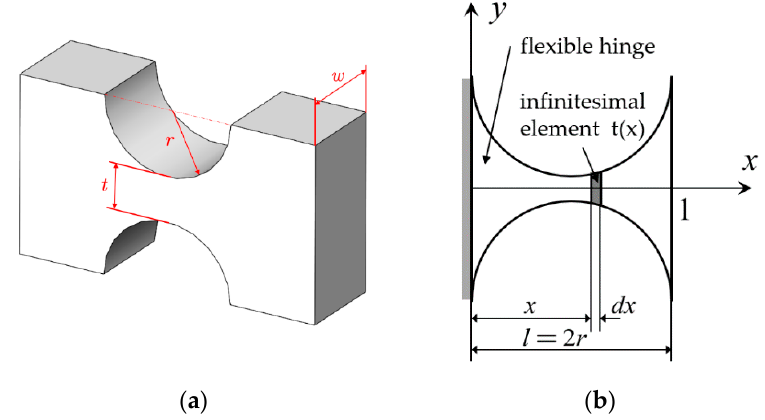
Figure 3. Flat single-axis straight circular flexible hinge. ( a ) Three-dimensional model, ( b ) Plane model.